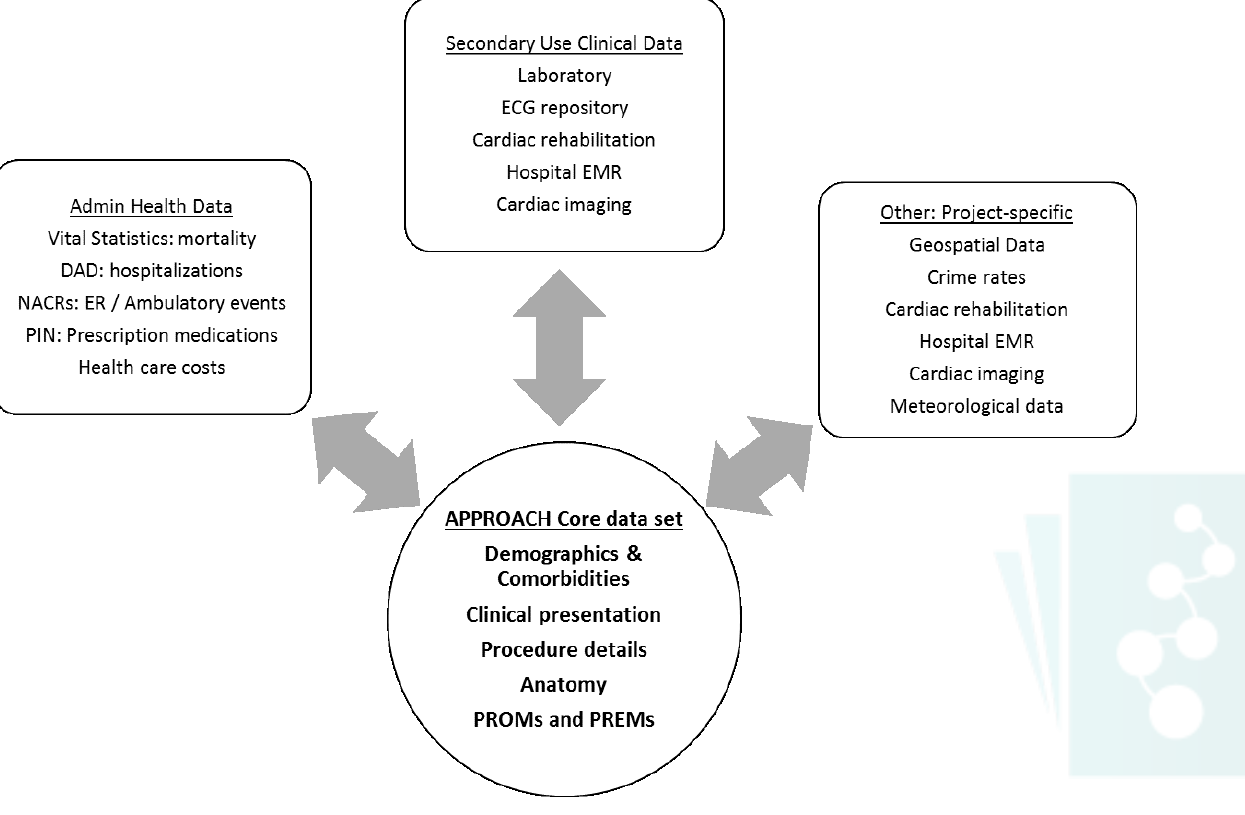
Figure 5: Data sources to which APPROACH clinical registry is linkable (DAD: Discharge Abstract Data; NACRS: National Ambu- latory Care Reporting System; ER: Emergency Room; PIN: Pharmaceutical Information Network; ECG: Electrocardiogram; EMR: Electronic Medical